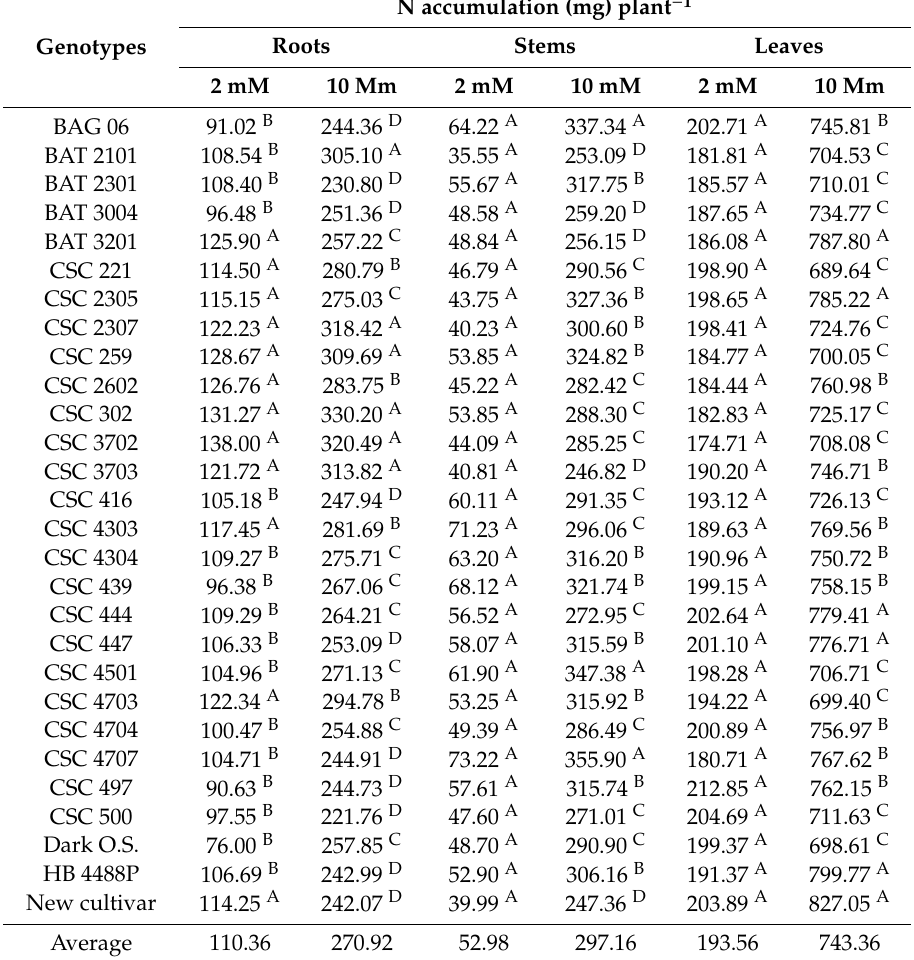
Table 3. Means of N accumulation (mg) in the roots, stems, and leaves for 28 tobacco genotypes grown at 2 and 10 mM of